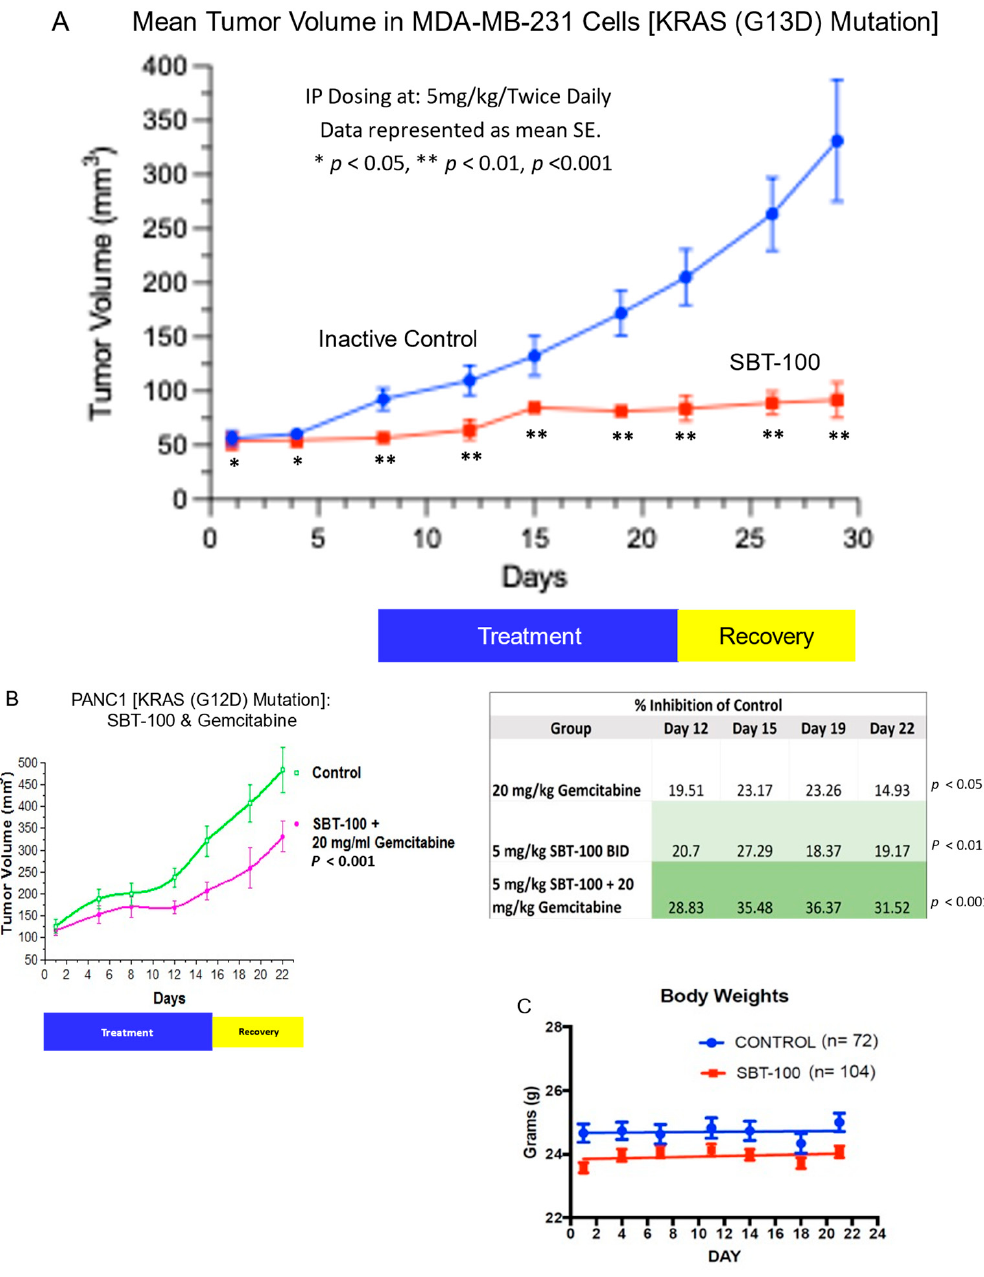
Figure 7. SBT-100 reduces tumor growth in mouse tumor xenograft models. ( A ) Athymic nude mice were injected with MDA-MB-231 cells subcutaneously in their right flanks. Once tumors were between 50–100 mm 3 , mice were treated with either saline vehicle or SBT-100 (5 mg/kg, BID) via intraperitoneal injection for 14 days until sacrifice. ( B ) Athymic nude mice were injected with Panc-1 cells subcutaneously in their right flanks. Once tumors were between 100 mm 3 –150 mm 3 , mice were treated with saline vehicle, gemcitabine (20 mg/kg, every third day), SBT-100 (100 mg/kg, BID), or combination gemcitabine and SBT-100, all via intraperitoneal injection for 14 days. After this 14-day period of treatment, there was a 7-day period of just observation. No weight loss or toxicity occurred in any of the treated mice. ( C ) In pooled data of mice weights from multiple studies. Mice treated with SBT-100 did not lose weight or show any signs of toxicity over the 3 weeks during these xenograft studies.